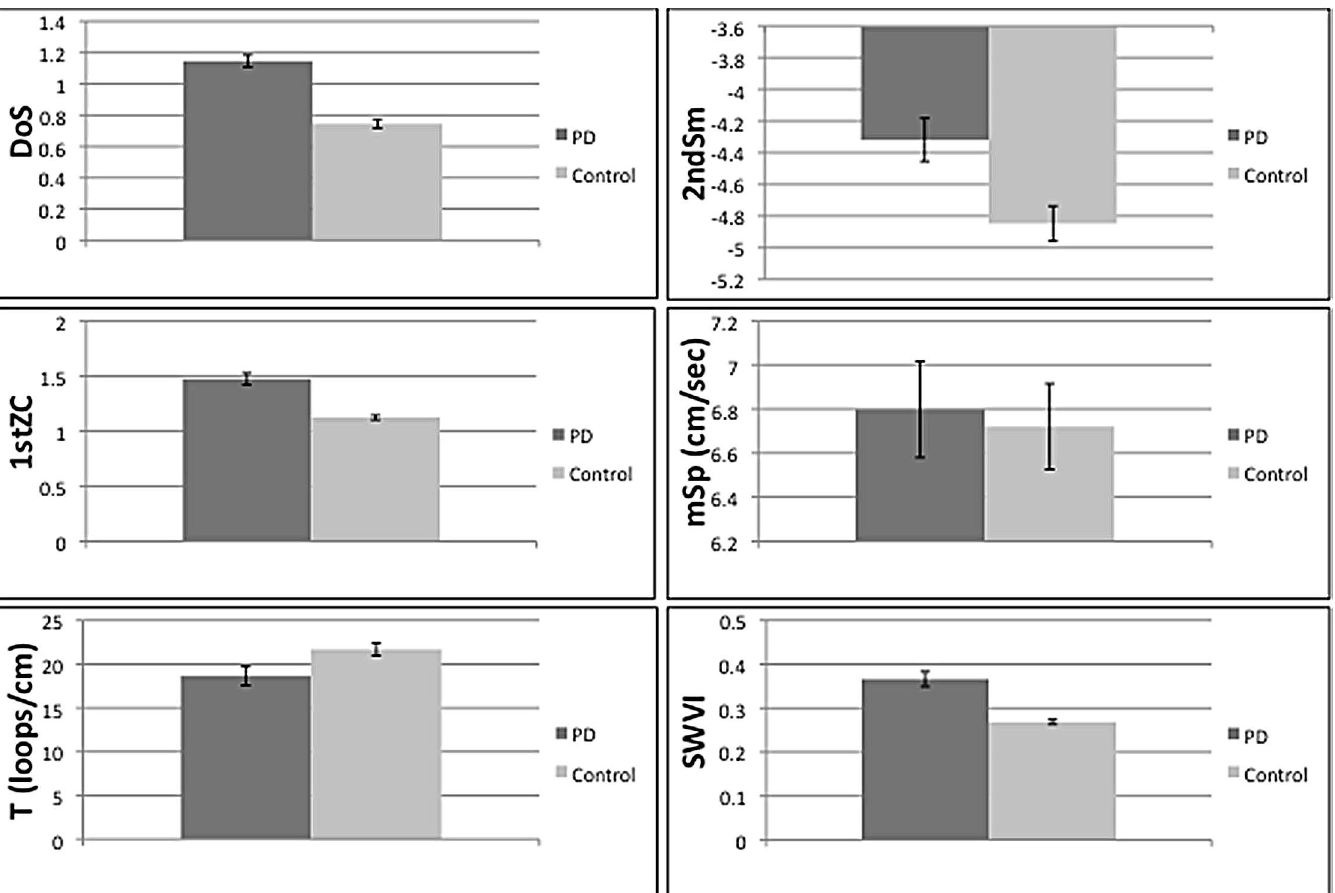
Fig 2. Spiral analysis indices in PD and controls. * p < 0.05, mean spiral values presented except for SWVI (median).